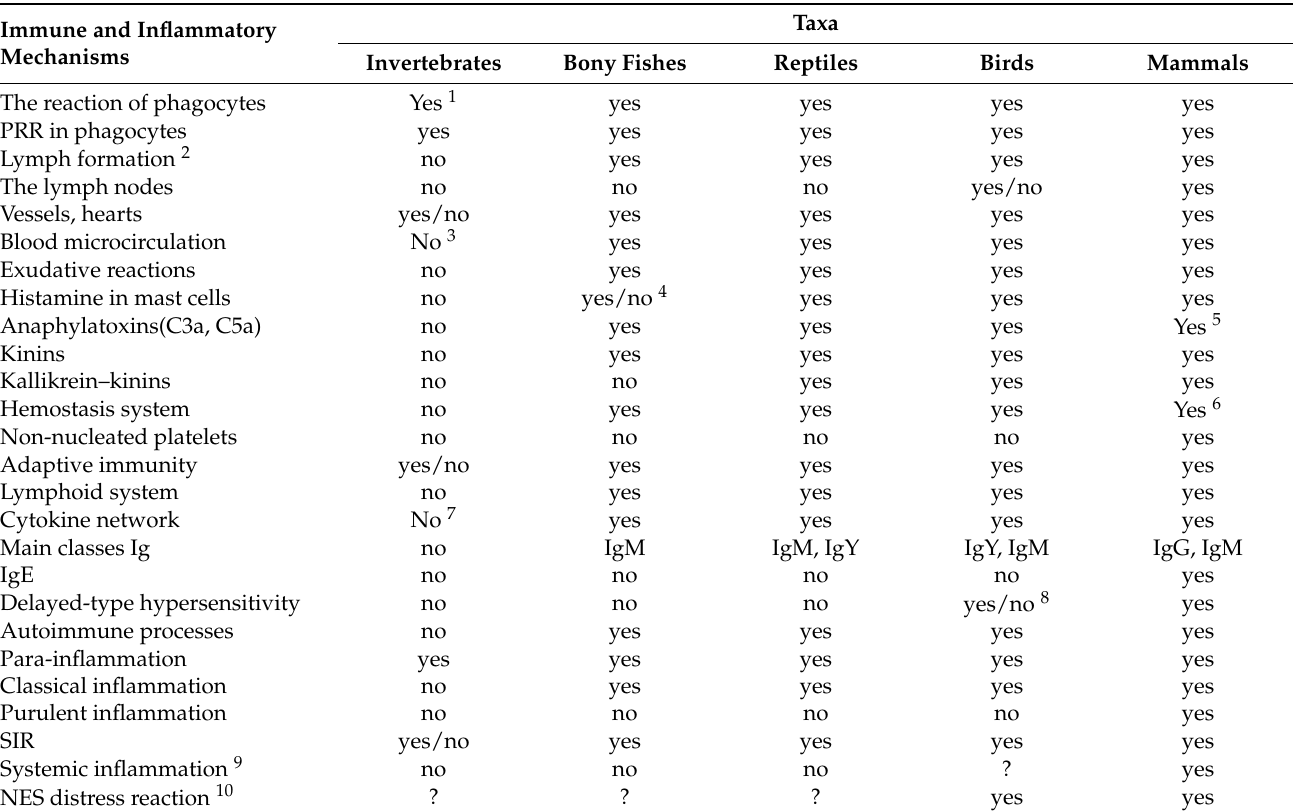
Table 3. Evolutionary patterns of inflammation and immunity [331,332].